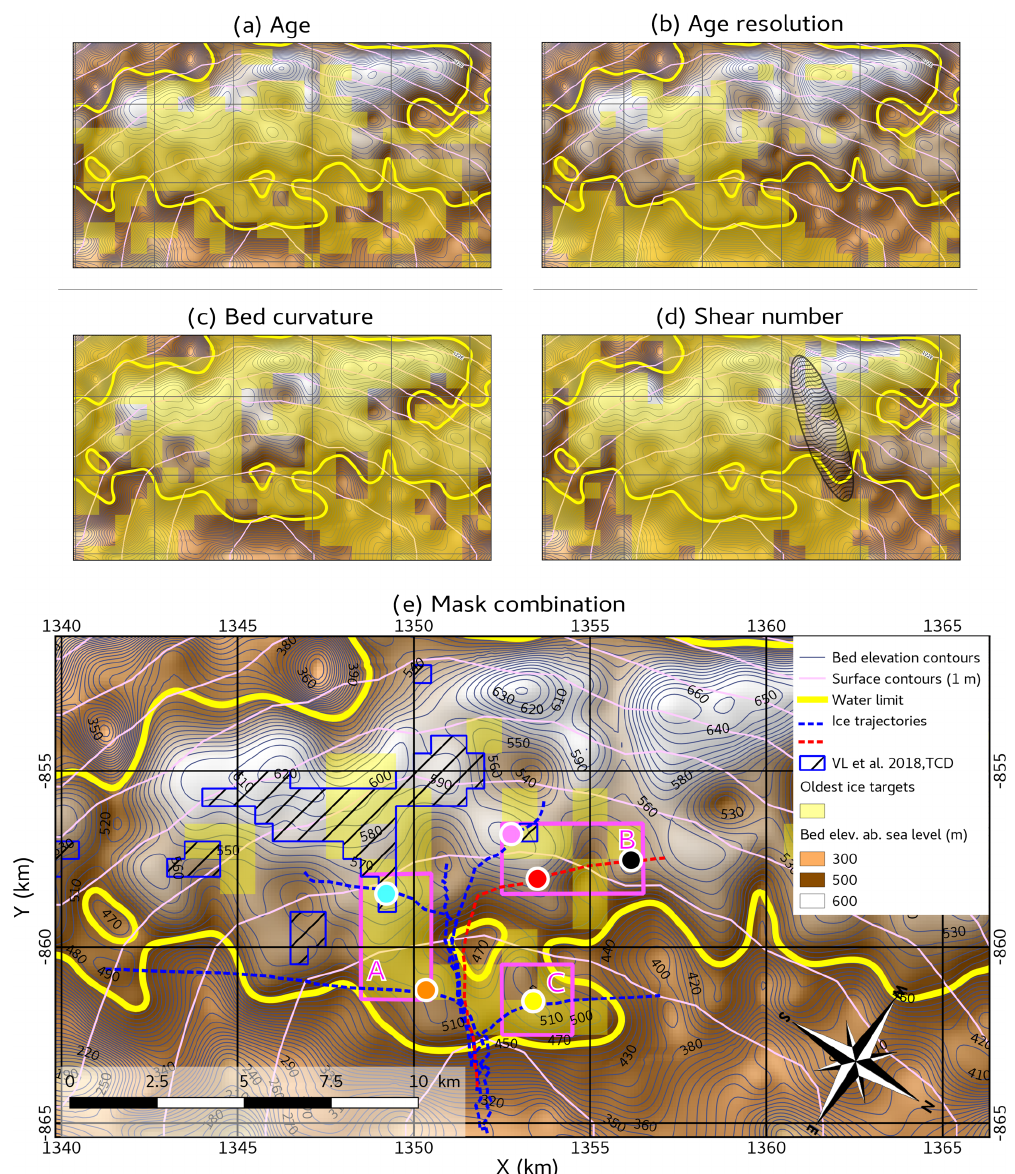
Figure 2. Selection criteria thresholded as follows (yellow areas): (a) age > 1 . 8Myr, (b) age resolution < 8 . 5kyrm − 1 , (c) bed curvature < 2 × 10 − 5 m − 1 , (d) shear number S < 40, (e) Boolean combination of the selection criteria. The water limit corresponds to a bed height of 480m and is shown here by a thick yellow contour. In panel (d) the elliptical wavy area corresponds to a region of higher shear. Magenta boxes A, B and C correspond to areas that could be considered as our best oldest-ice targets. Dashed lines show trajectories of ice particles; the red one corresponds to the profile presented in Fig. 3. Colored points locate possible drill sites, discussed in the text. Hatched areas show the best areas of Van Liefferinge et al. (2018). All the panels cover the same area. This figure focuses on the bedrock high designed as such in Fig. 1, located ∼ 40km southwest of the Dome C summit. Projection: WGS84/Antarctic Polar Stereographic – EPSG:3031